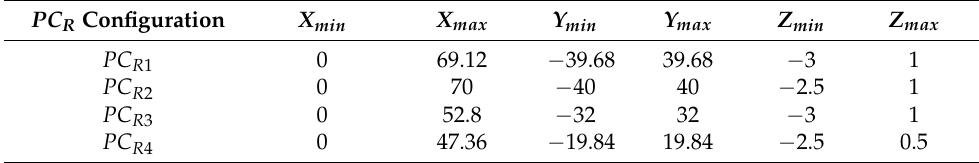
Table 3. The different point cloud ranges ( PC R ) configurations used in